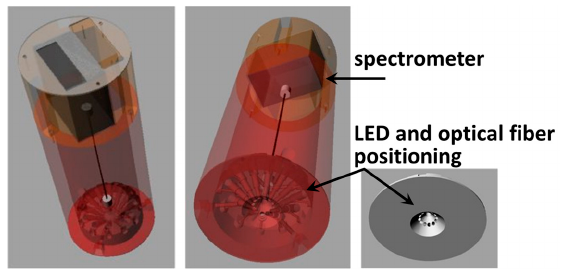
Figure 8. Rendering of the spectrometer-based colorimeter SpiderSpec. Reproducted from [31] with permission from SPIE.